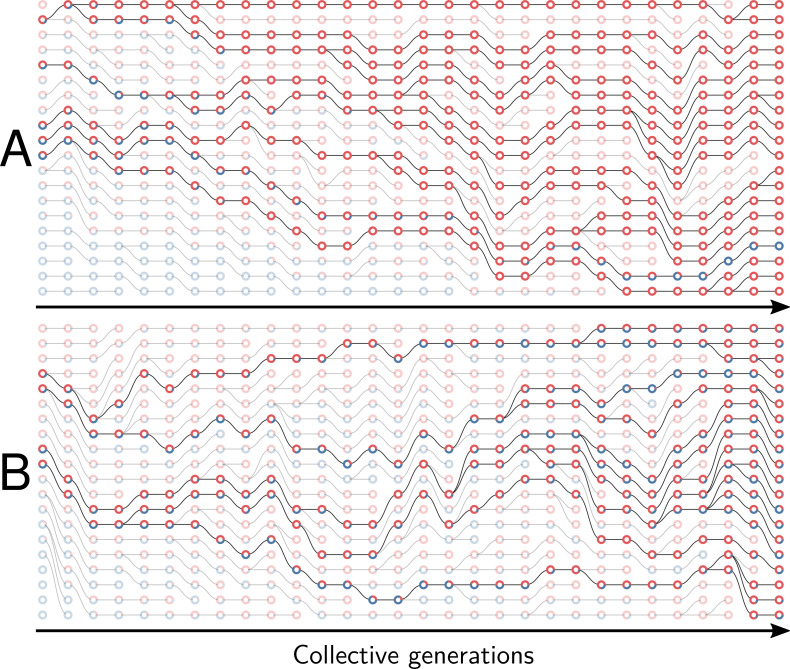
Example of collective genealogy (Supplement of Figure 2).Symbols and colours are as in Appendix 1—figure 1 and extinct lineages are marked transparent. Collective-level parameters in this simulation are M=30,D=20,ρ=0.1. A. Neutral regime: at the final generation, collectives are monochromatic and most likely composed of the faster-growing type. B. Selective regime: at the final generation, collectives contain both red and blue particles.